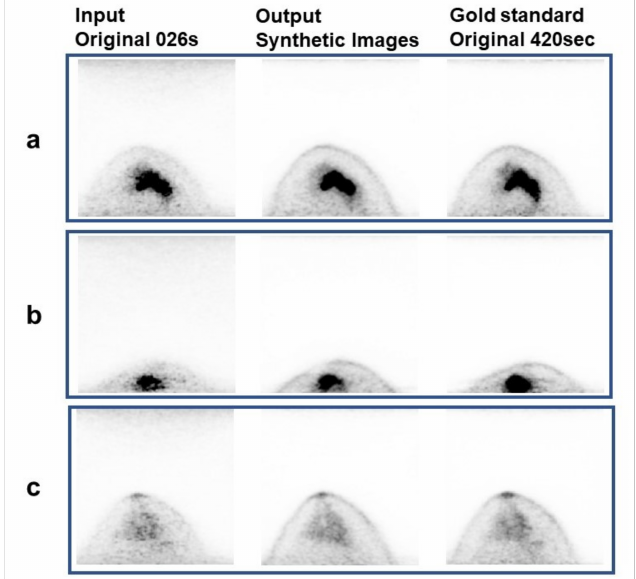
Figure 3. Examples of synthetic images. The left row shows the input (original images), the middle row shows the output (synthetic images), and the right row shows the gold standard (original 420-s acquisition images). ( a , b ) Breasts with abnormal accumulation. ( c ) Normal